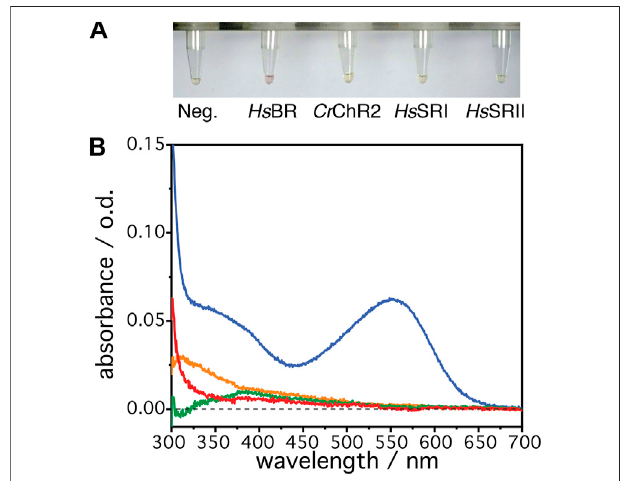
FIGURE 1 | (A) The resultant solutions from the cell-free expression at 25 ° C, 8 h after the addition of the individual DNA plasmid. From left to right: Negative control (no DNA), bacteriorhodopsin ( Hs BR), channelrhodopsin II ( Cr ChR2), sensory rhodopsin I ( Hs SRI), and sensory rhodopsin II ( Hs SRII). (B) UV/visible absorption spectra of the resultant solutions of Hs BR (blue), Hs SRI(green), Hs SRII(red),and Cr ChR2(orange).Thesolutionwiththe negative control was used for the reference spectrum to compensate absorption from the free retinal in the solution and other